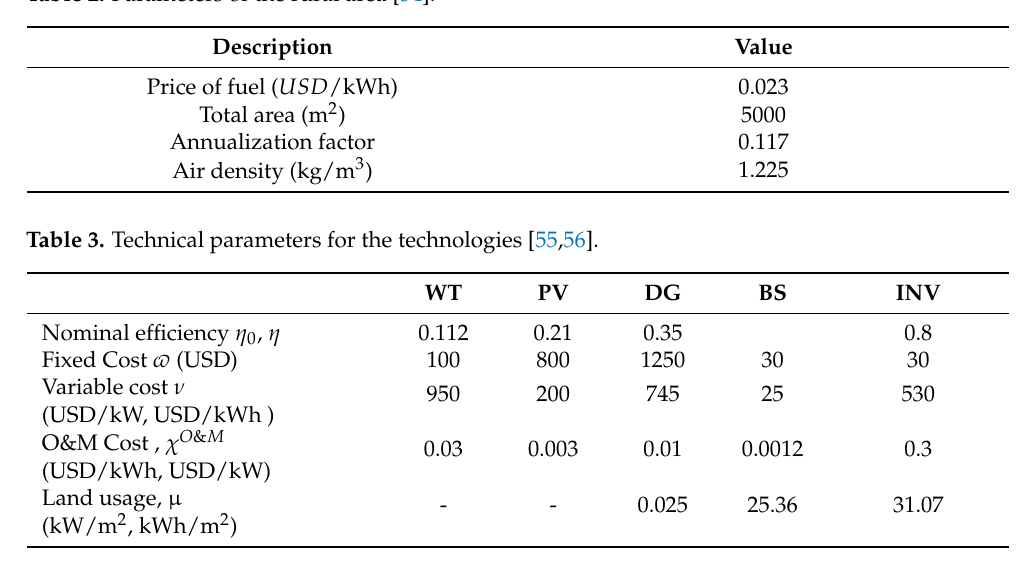
Table 2. Parameters of the rural area [54].